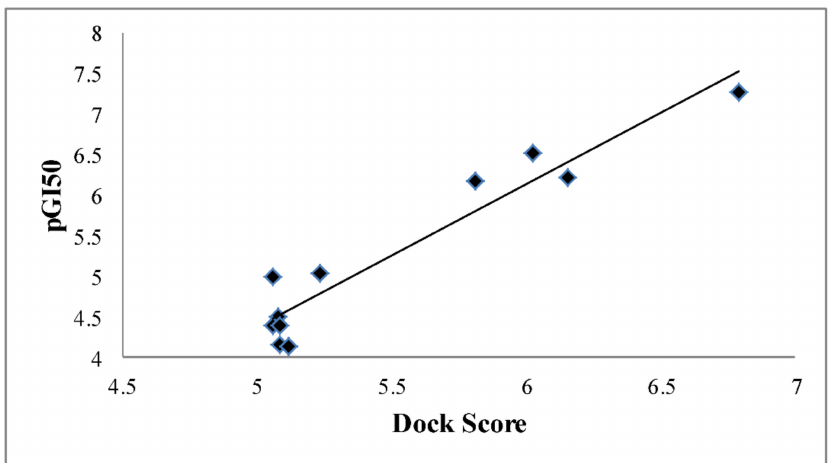
Figure 4. Correlation between the biological activity of synthesized compounds and their dock scores in Glide